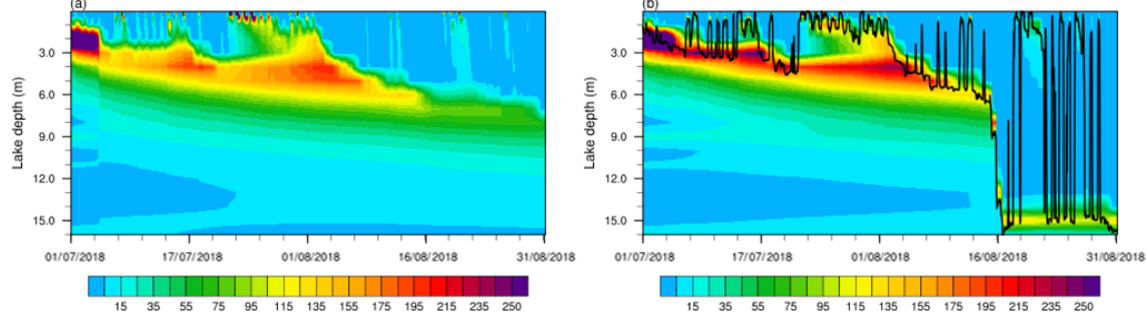
Figure 5. Simulated N 2 with (a) CLM-ORG and (b) CLM-KPP (unit: 10 − 5 s − 2 ). The black line in (b) shows the lake boundary layer depth (unit: m).